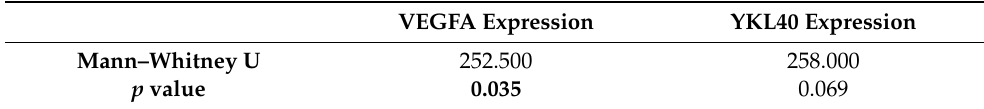
Table 7. Mann–Whitney U test analysis of statistical differences regarding the expression of VEGFA and YKL40 between good responders (PFS-2 > 6 months) and bad responders (PFS-2 ≤ 6 months) to bevacizumab